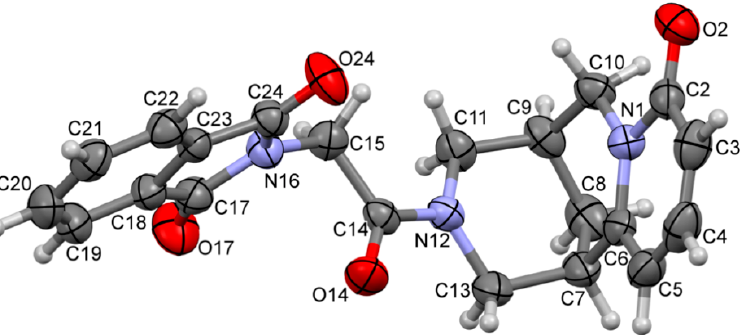
Figure 3. A perspective view of the molecule 3A . Ellipsoids are drawn at the 50% probability level, hydrogen atoms are represented by spheres of arbitrary radii.